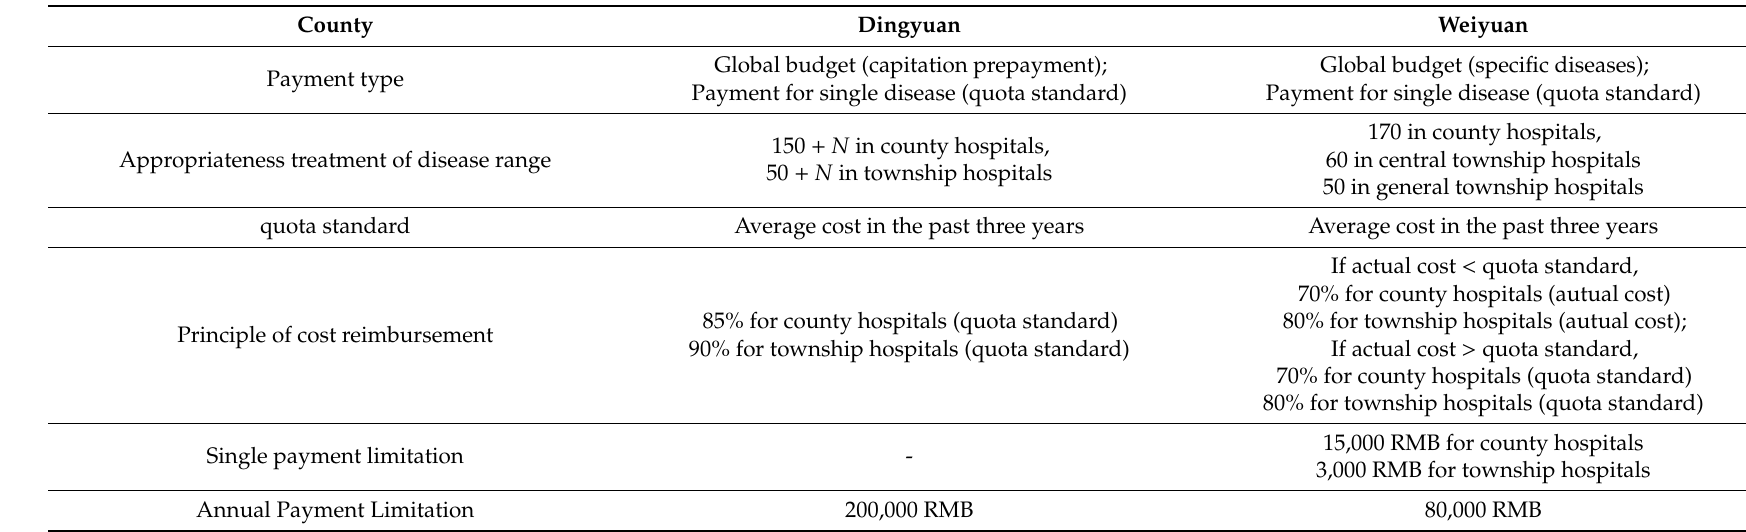
Table 2. The di ff erences in the specific payment methods design between two